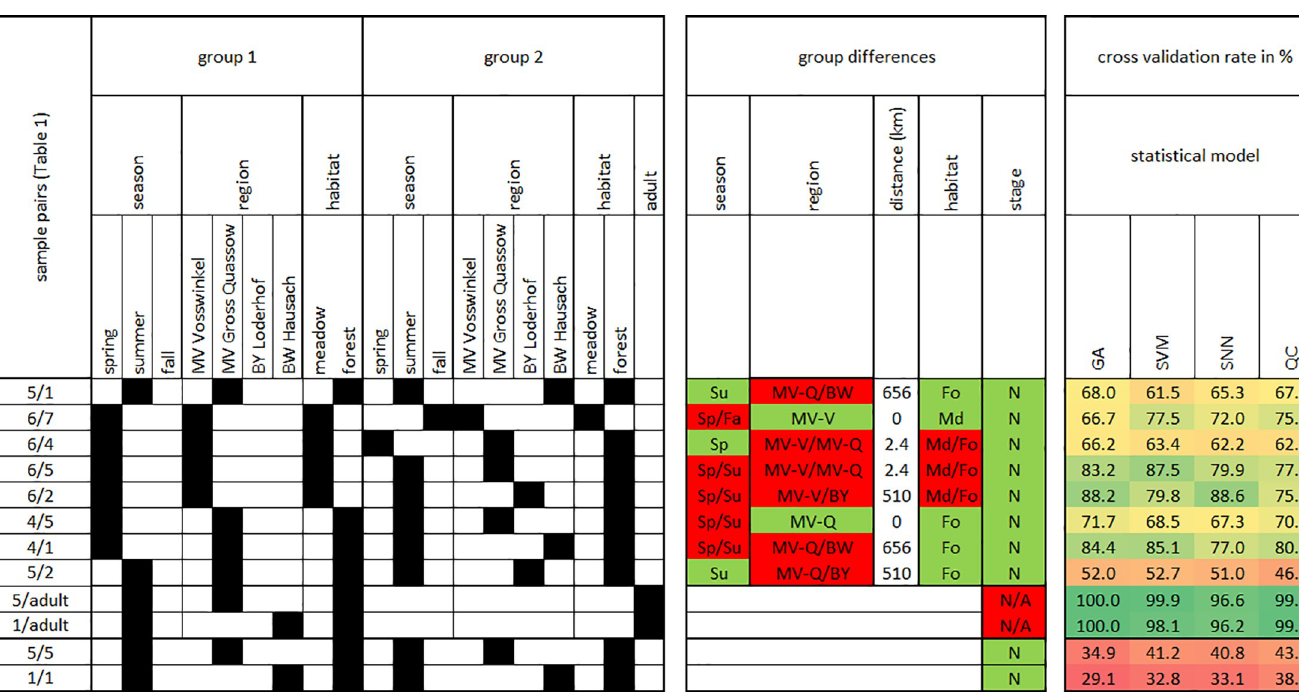
PLOS ONE | https://doi.org/10.1371/journal.pone.0210590 January 15,